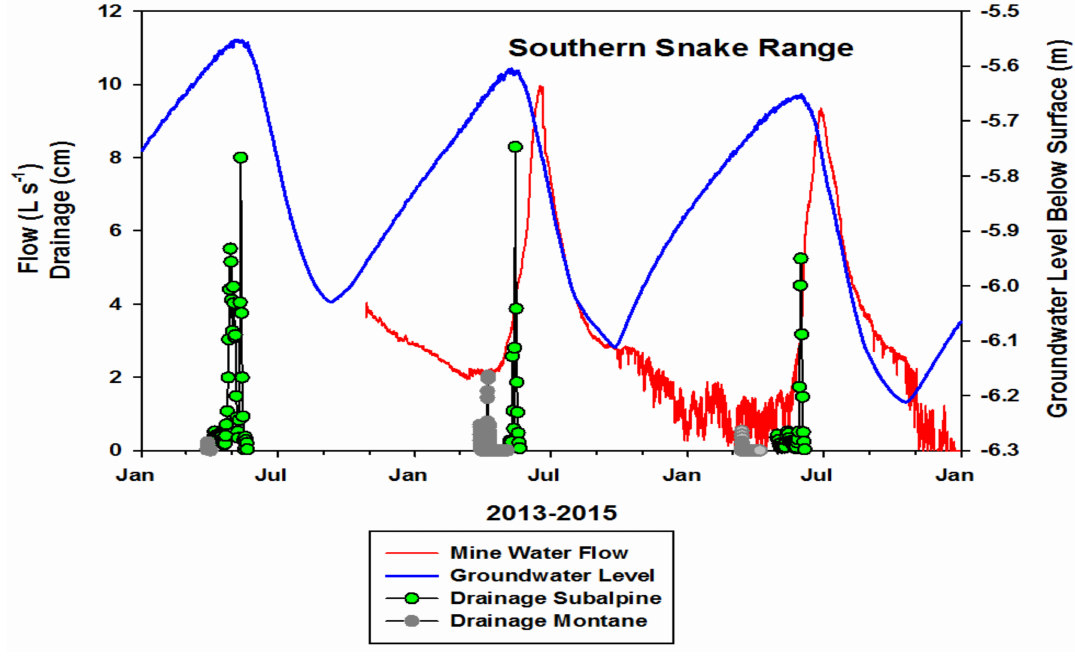
Figure 5. Mine flow, groundwater levels (Spring Valley) and drainage volumes daily at both the Montane and Subalpine sites during 2013–2015 time